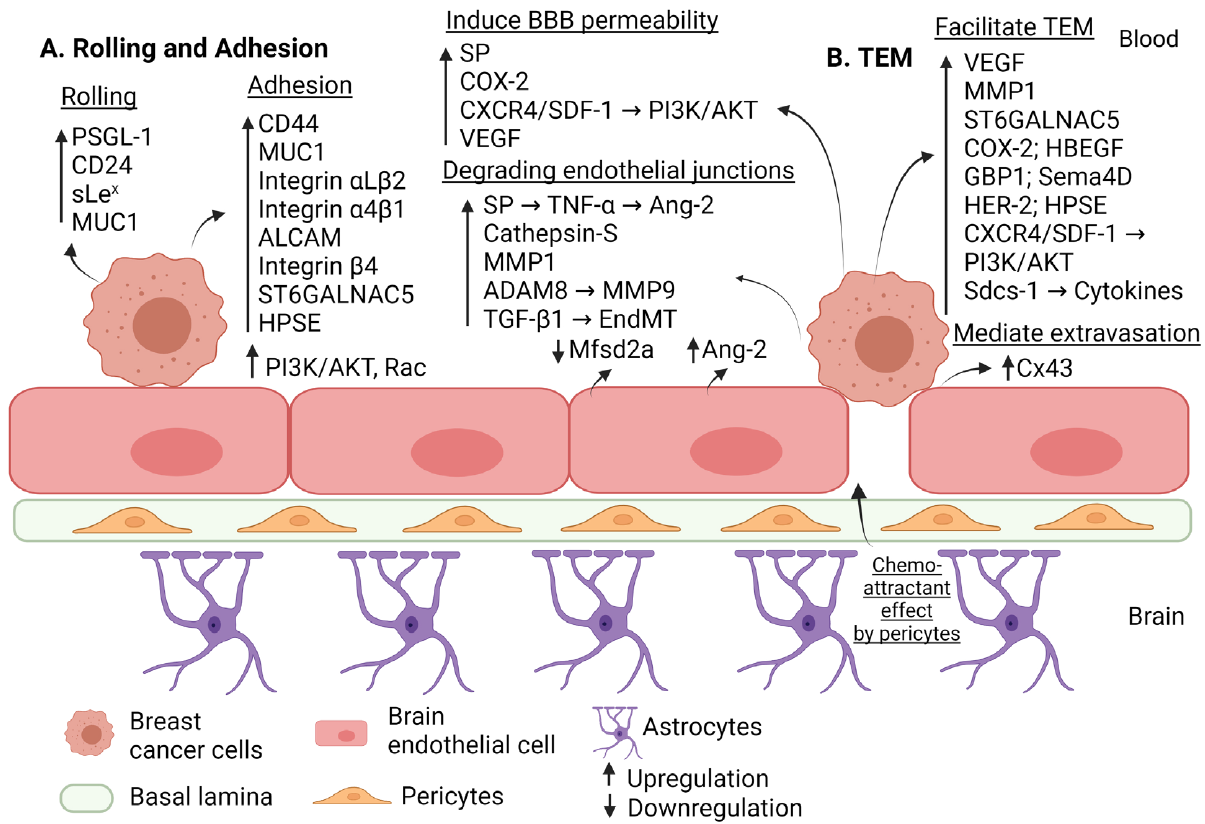
Figure 1. Schematic representation of extravasation steps in breast cancer brain metastasis. ( A ) Rolling and firm adhesion: Rolling and firm adhesion are the first two steps occurring during extravasation, in which ligands expressed on breast cancer cells interact with respective molecules expressed on BECs. During rolling, breast cancer cells express ligands, including PSGL-1, CD24, sLex, and MUC1 that interact with endothelial E-selectin. During adhesion, additional ligands expressed on breast cancer cells, including CD44, MUC1, LFA- 1 (Integrin αLβ2), VLA - 4 (Integrin α4β1), AL- CAM, and Integrin β4 , interact with adhesion molecules expressed on the BEC, including VCAM-1 and ICAM-1 to allow the firm adhesion of breast cancer cells on the BEC [28,29]. Mechanistically, through the inflammation and upregulation of PI3K/AKT, Rac signaling pathways have been shown to induce expression of adhesion molecules and promote the adhesion of breast cancer cells on the BE [74]. ( B ) Trans-endothelial migration: Enhanced permeability of BBB in breast cancer BM is me- diated by upregulation of inflammatory mediators, including the COX2 and MMPs, leading to the disruption of inter-endothelial junctions, including (ZO-1 and claudin-5) [43]. Upregulation of CXCR4/SDF1 signaling pathway induces vascular permeability and TEM through activating PI3K/AKT and calcium signaling [73]. Upregulation of VEGF increases the permeability of BBB through redistributing actin fiber and disrupting VE-cadherin, thus promoting TEM. Cathepsin-S induces proteolytic cleavage of JAM-B, ADAM8 upregulates MMP9, and EndMT decreases VE-cad- herin levels. Other mediators of breast cancer cells TEM include VEGF, MMP1, ST6GALNAC5, COX2, HB-EGF, GBP1, Sema4D, HER2, HPSE, CXCR4/SDF1, PI3K/AKT, Sdcs-1, and Cx43. Pericytes exert a chemoattractant effect on breast cancer cells to promote TEM [38]. Photo created with Bio- Render.com.